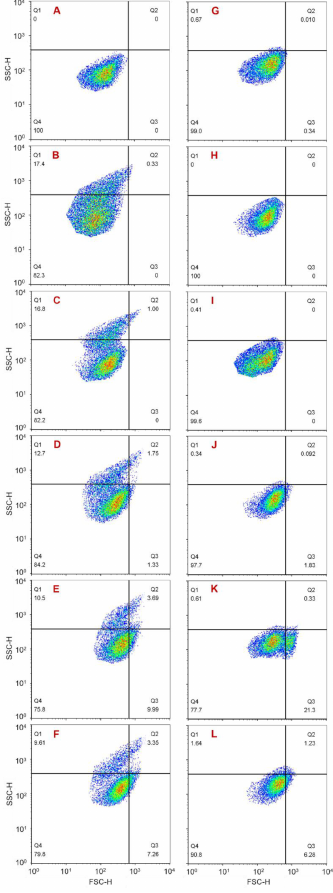
Figure 6. Changes in cytoplasmic granularity of residual cells within 96 h after treatment with NC or MC. ( A , G ) Normal cells measured at 3 h and 96 h, respectively (group 1); ( B – F ) residual cells treated with NC measured at 3 h, 24 h, 48 h, 72 h, and 96 h, respectively (group 2); ( H – L ) residual cells treated with MC measured at 3 h, 24 h, 48 h, 72 h, and 96 h, respectively (group